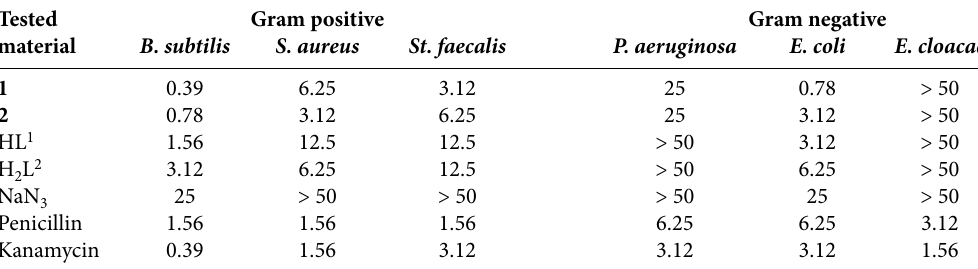
Table 4. MICs (μg mL –1 ) of the compounds and related materials Tested Gram positive Gram negative